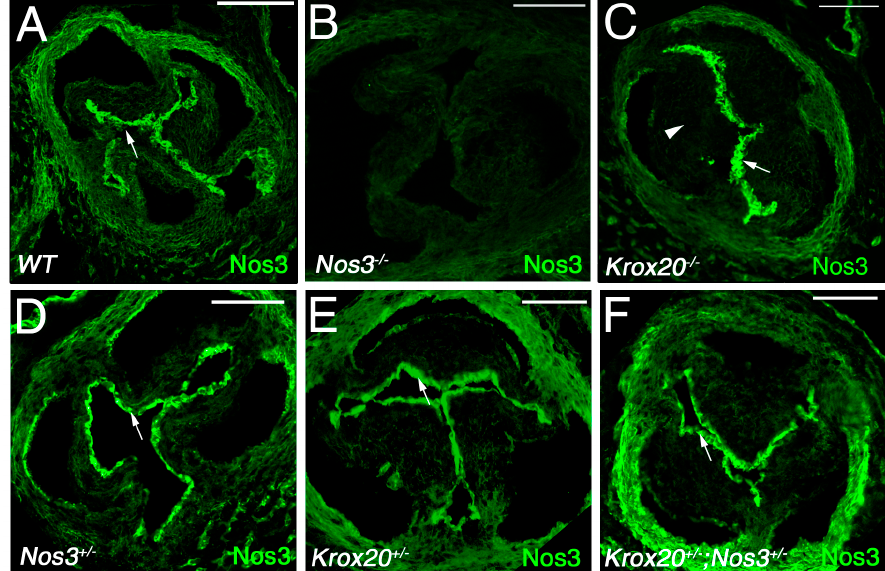
Figure 3. Endothelial nitric oxide synthase (Nos3) expression is altered in Krox20 deficient mice. ( A – F ) Immunohistochemistry showing Nos3 protein (green) in the aortic valve of wild-type (WT, A ), Nos3 − / − ( B ), Krox20 − / − ( C ), Nos3 +/ − ( D ), Krox20 +/ − ( E ), and Nos3 +/ − ; Krox20 +/ − ( F ) embryos at E18.5. Immunohistochemistry showing abundant expression of Nos3 in the valve endothelial cells (arrows). Note the reduction of Nos3 expression in the mesenchyme of Krox20 − / − ( C ) aortic valve leaflets (arrowhead; compared C with A ). Scale bars: 100 μ m.